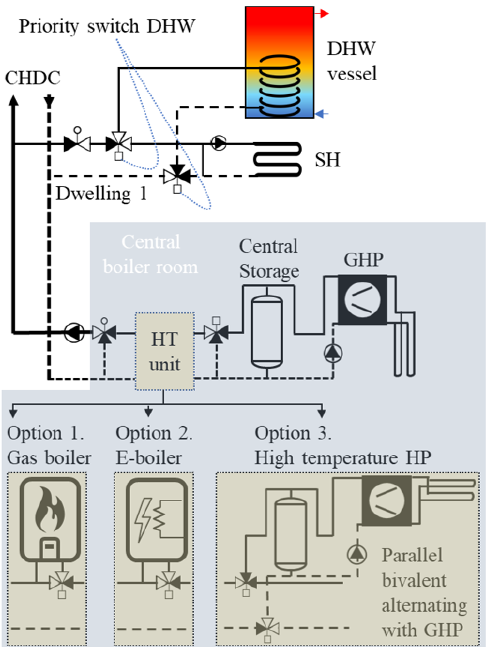
Figure 1. Overview of the case study. Each dwelling is equipped with underfloor heating and a domestic hot water (DHW) vessel. The central production consists of a geothermal heat pump (GHP) and an high-temperature-unit (HT-unit, i.e., gas boiler, e-boiler, or high-temperature heat pump